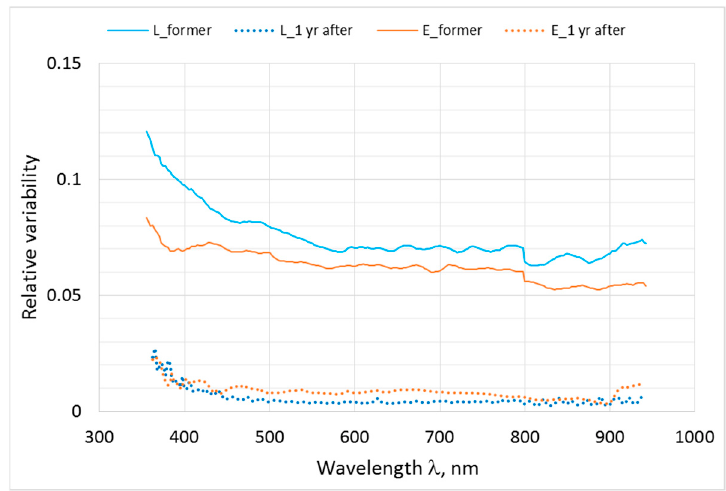
two different lamps used for calibration before LCE-2 and a year later before FICE-AAOT.